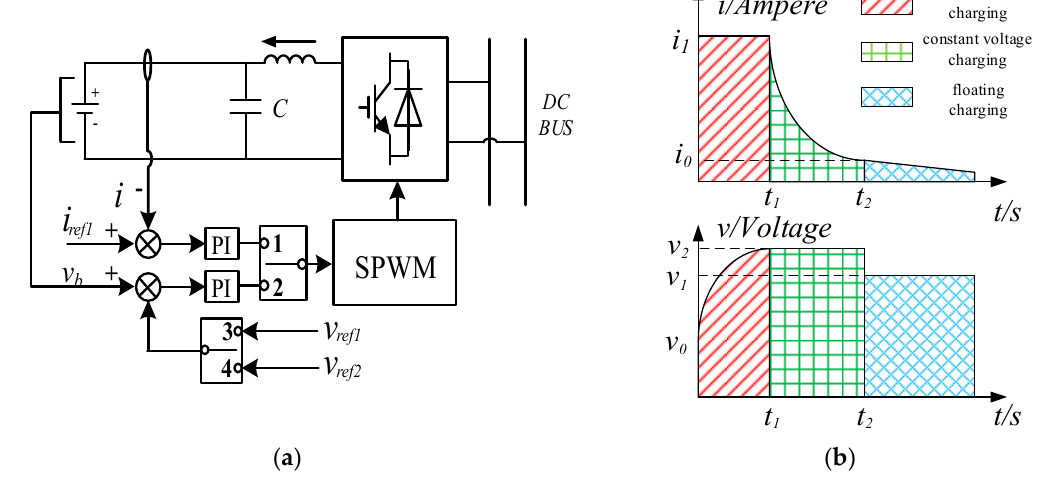
Figure 9. Battery charging management scheme: ( a ) Block diagram of energy storage battery control strategy during charging. ( b ) Energy storage battery charging stage diagram.